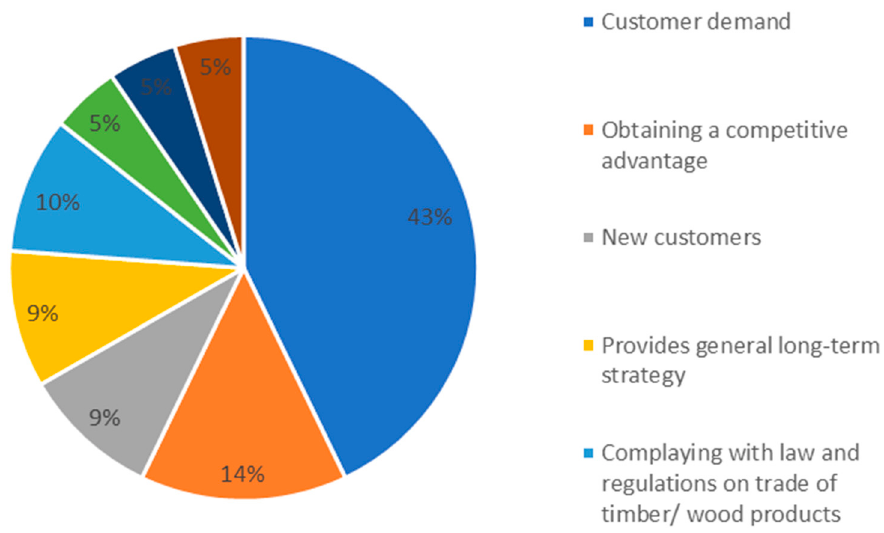
Figure 5. Perceived drivers toward FSC.